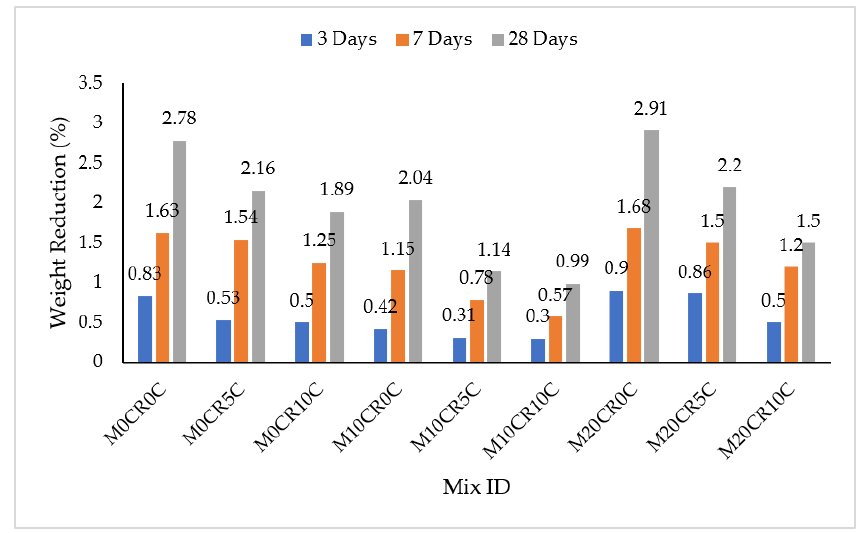
Figure 4. Immersion periods in MgSO 4 for SCC mixes containing CR and CCW.